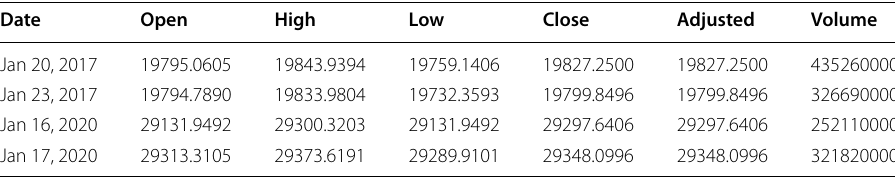
Table 2 Part of DJIA index daily prices